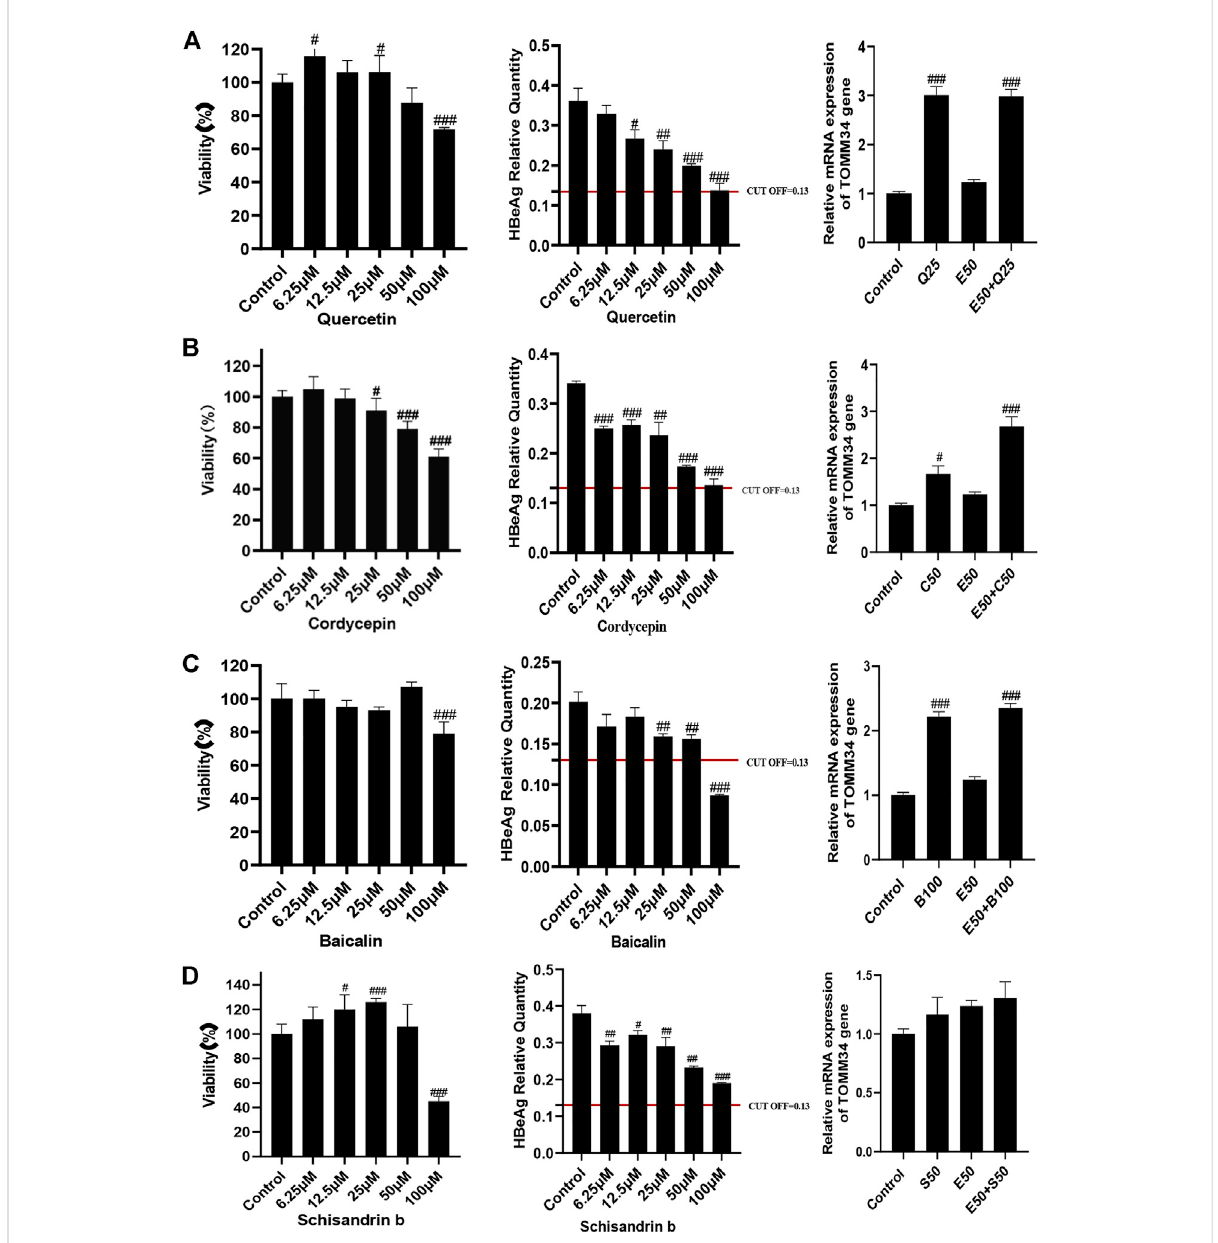
FIGURE 9 Effects of 4 active compounds of FZHY on the viability of HepG2.2.15 cells and the HBeAg production and TOMM34 gene expression in HepG2.2.15 cells. (A) Quercetin. E50: 50 μ g/ml ETV, Q25: 25 μ M Quercetin. (B) Cordycepin. E50: 50 μ g/ml ETV, C50: 50 μ M